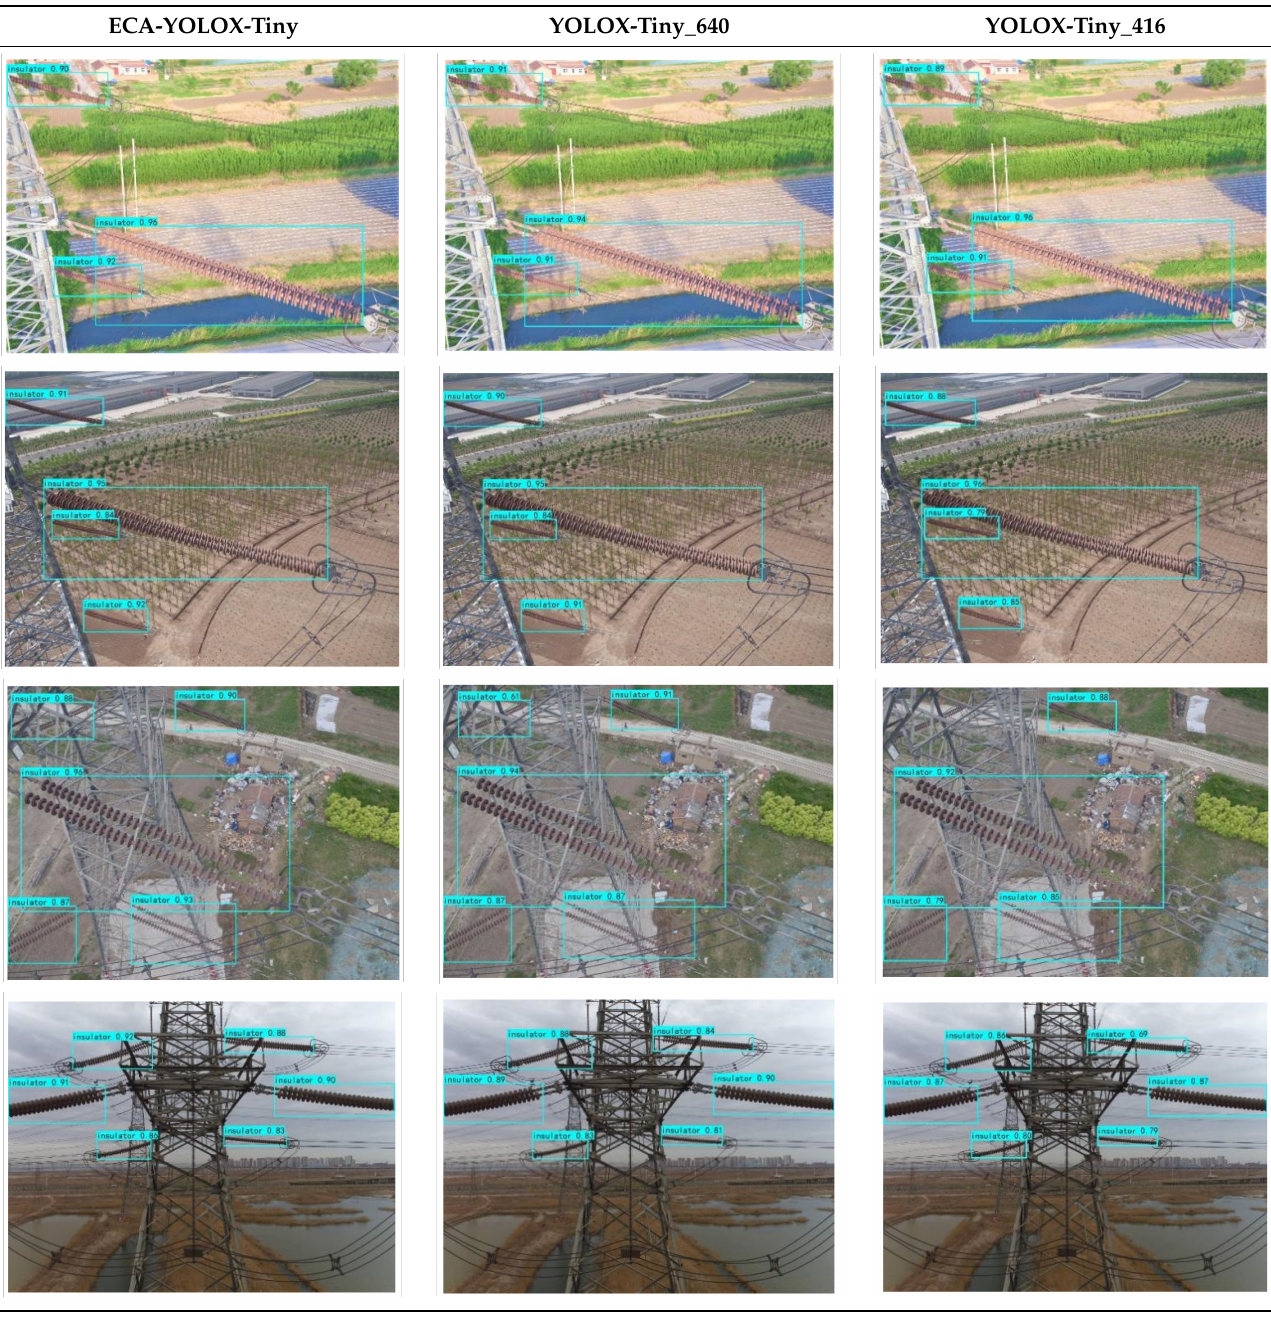
Table 5. The multi-target detection results of normal insulators before and after the model